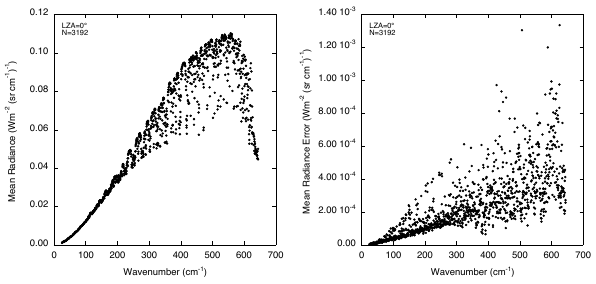
Figure 5. The mean FIR radiance spectrum based on all LBLRTM simulations performed with the 3192 radiosonde profiles (left), and the spectral radiance estimation errors (regression rms errors) asso- ciated with them (right). All simulations shown are for a local zenith angle of 0 ◦ .